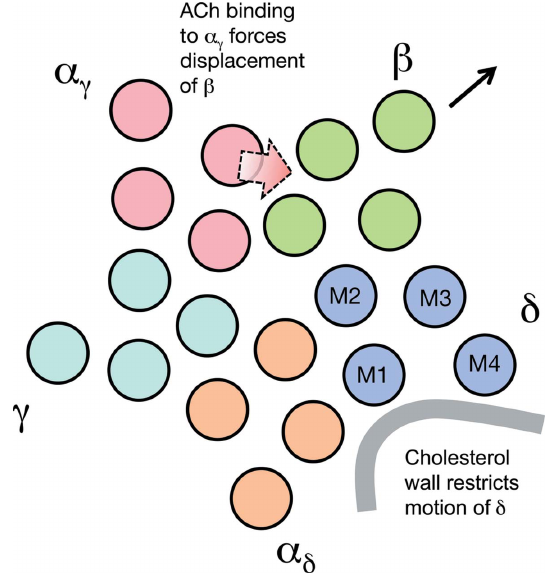
Figure 4 The positioning of a cholesterol-rich microdomain against the (cid:2) subunit suggests that cholesterol may play a mechanical role, restricting the mobility of (cid:2) so that (cid:5) can tilt outwards to open the channel. The movements leading to channel opening, depicted in the figure, are based on the results described in Unwin & Fujiyoshi (2012). ACh binding to the receptor in the extracellular domain causes (cid:3) (cid:4) to push against the extracellular part of (cid:5) (wide arrow), which is linked via (flexible) loops to the (cid:3) -helical membrane-spanning part. As a result, the (cid:3) -helical part of (cid:5) tilts outwards (thin